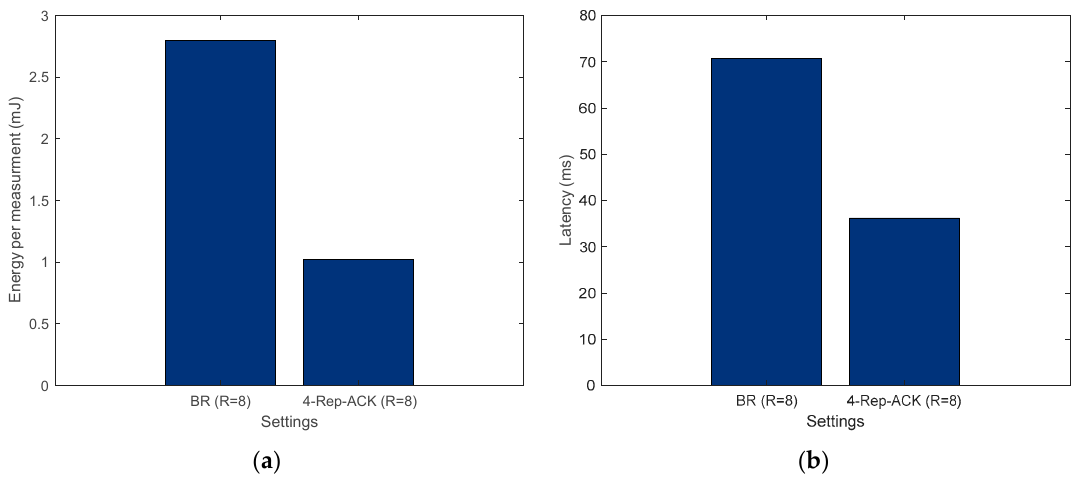
Figure 26. Meeting 99.999% reliability target by using BR and 3-Rep-ACK retransmissions.